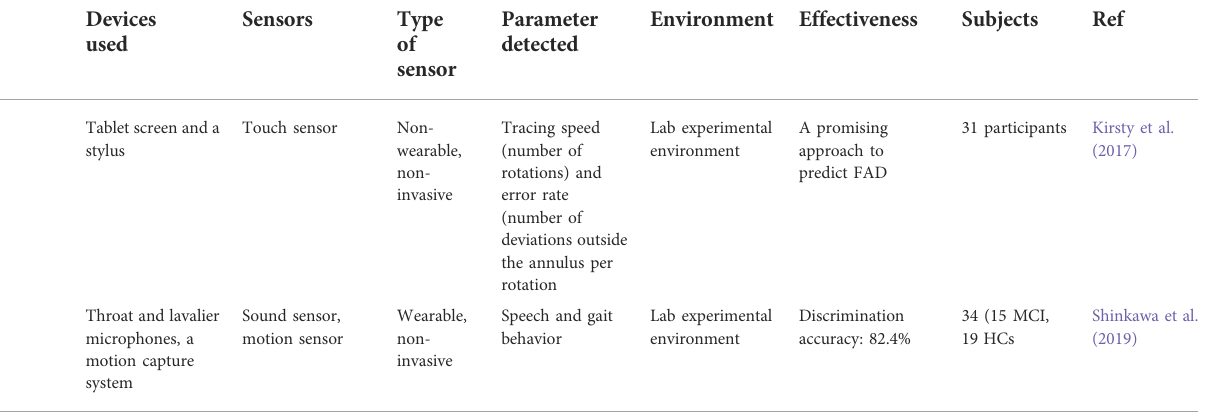
TABLE 4 ( Continued ) List of sensor-based multi-behavior detection toward AD